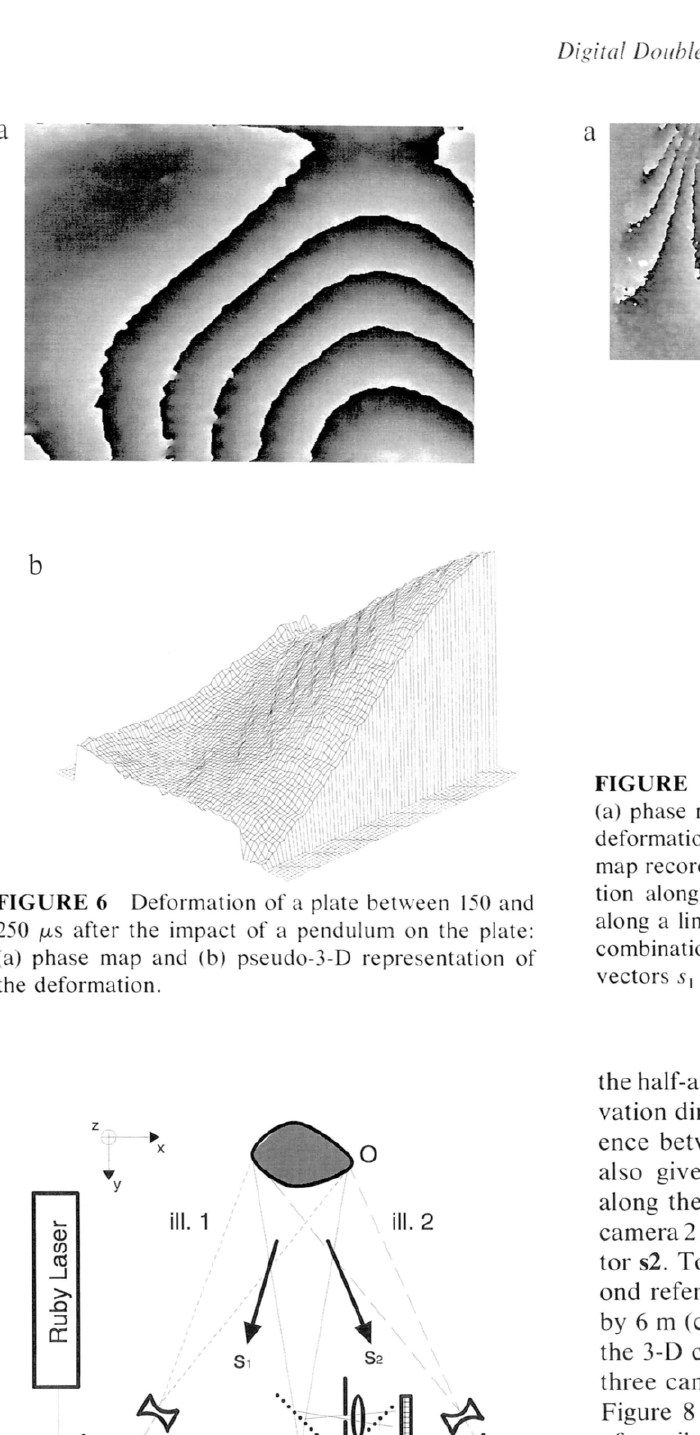
FIGURE 7 Optical setup for 2-D speckle interfer ometry.